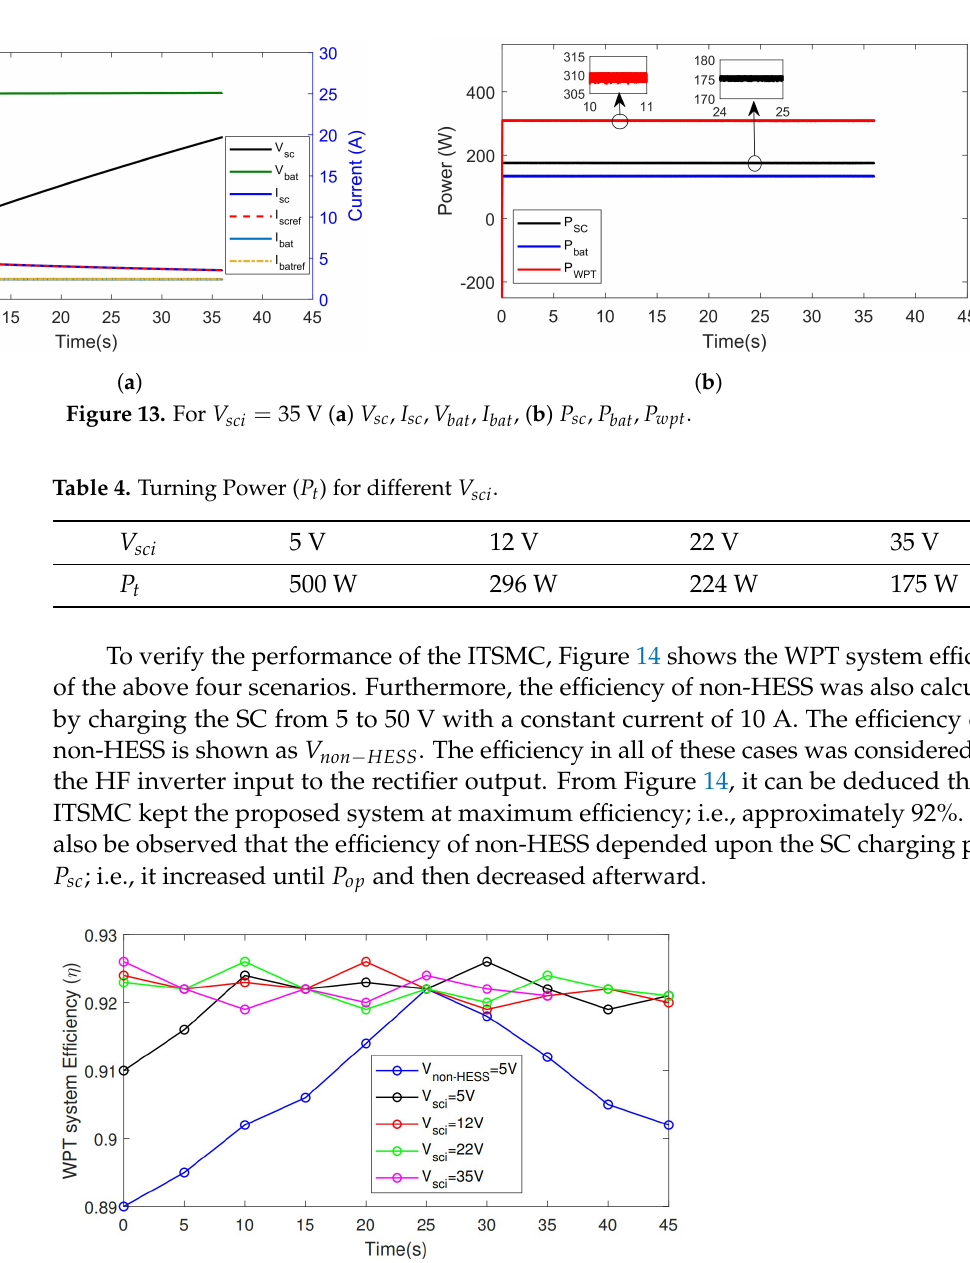
Figure 14. WPT system efficiency for different V sci and V non − HESS